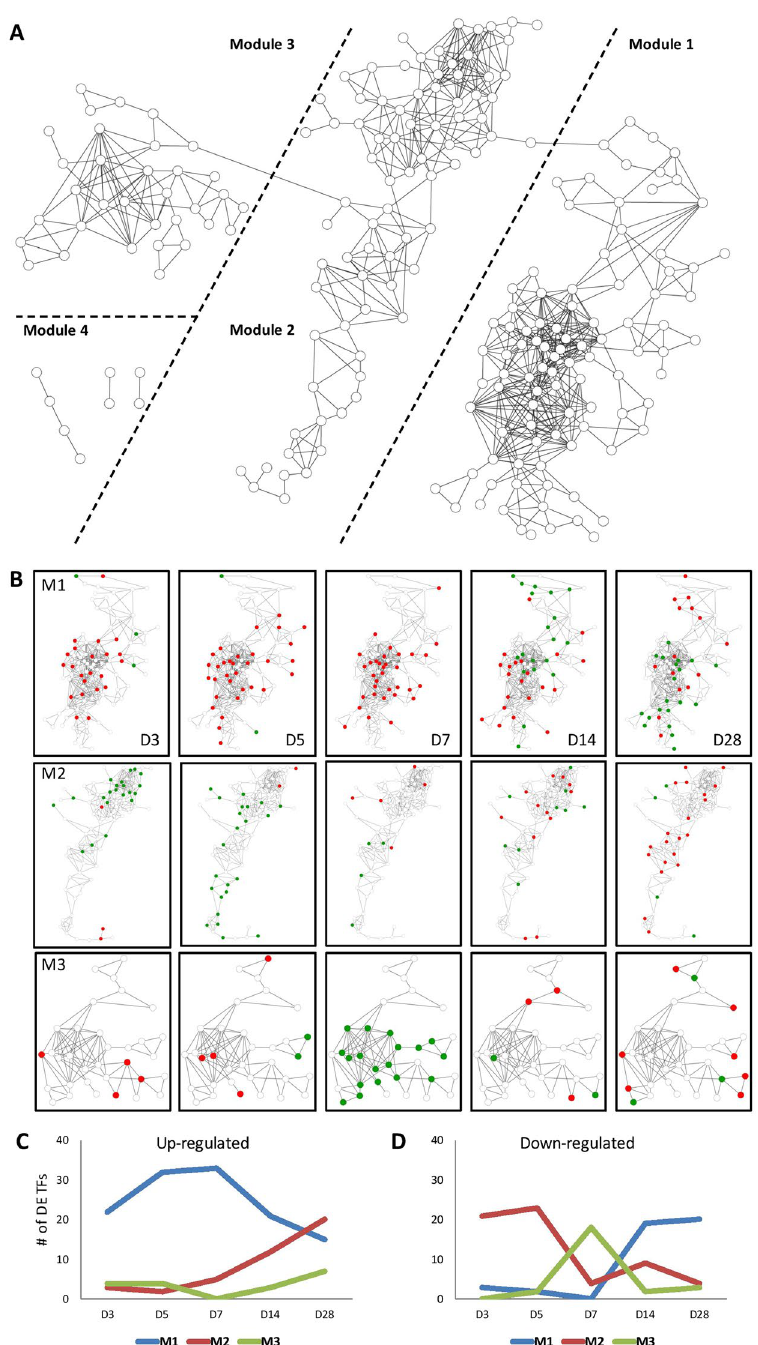
Figure 3. A positive gene coexpression network for differentially expressed (DE) TF genes under the TAB condition. ( A ) The four modules of TF genes in the network. ( B ) TF genes in Modules 1, 2 and 3 have different patterns of differential expression at each time point. The red and green nodes, respectively, indicate the up- and down-regulated TF genes at the time point. The line charts represent the numbers of ( C ) up-regulated and ( D ) down-regulated DE TF genes in Modules 1, 2 and 3 at different time